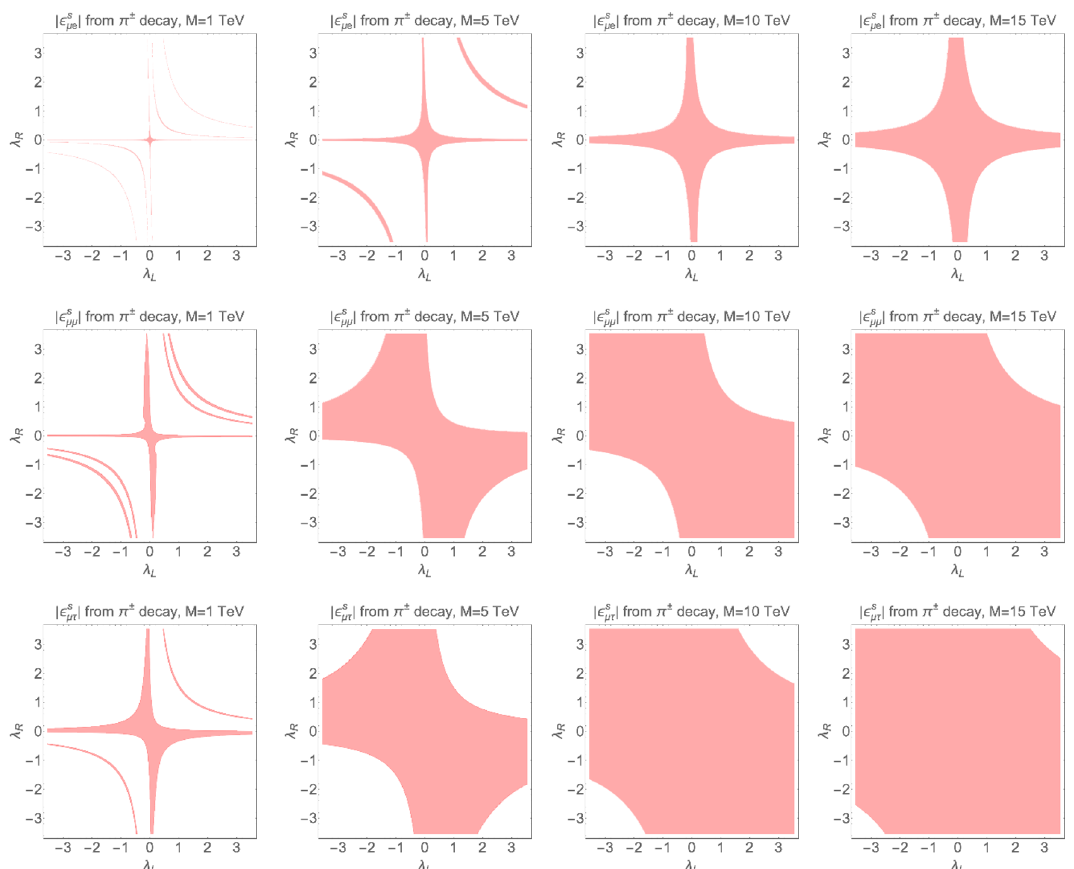
Figure 5 . Constraints on the simplified leptoquark model parameter space from current constraints on | (cid:15) s | ( ‘ = e, µ, τ ) summarized in table 4. The pink region(s) in each figure is (are) still allowed µ‘ at 95% CL, obtained by fixing λ L = λ R = 1 . See the main text for